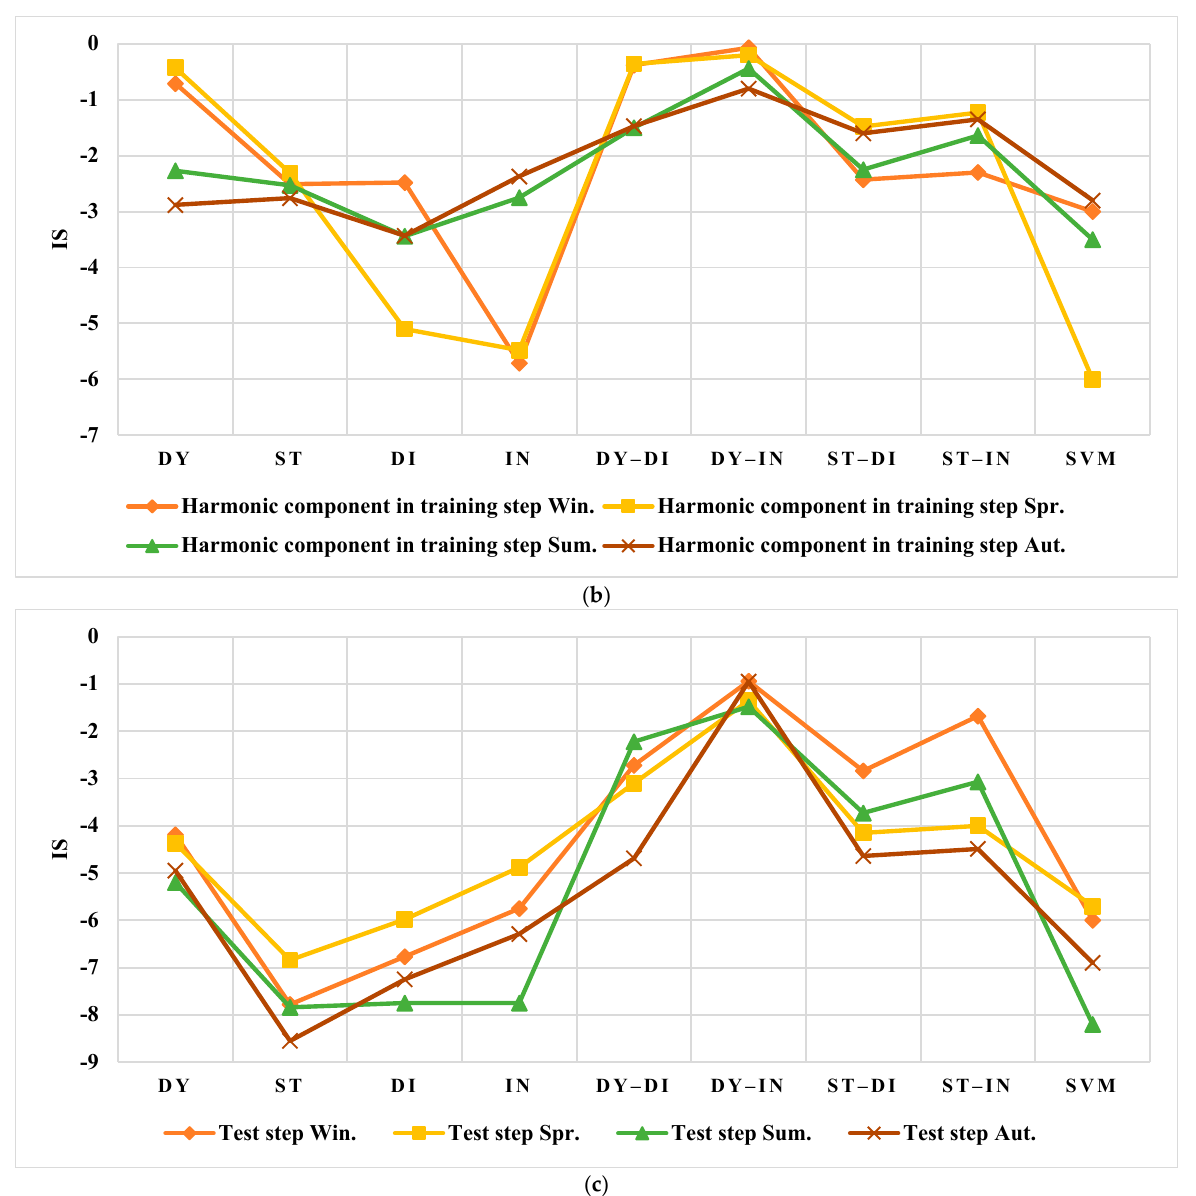
Figure 15. The results of average IS for Spain: ( a ) Main Component in training step, ( b ) Harmonic Component in training step, ( c ) Test step